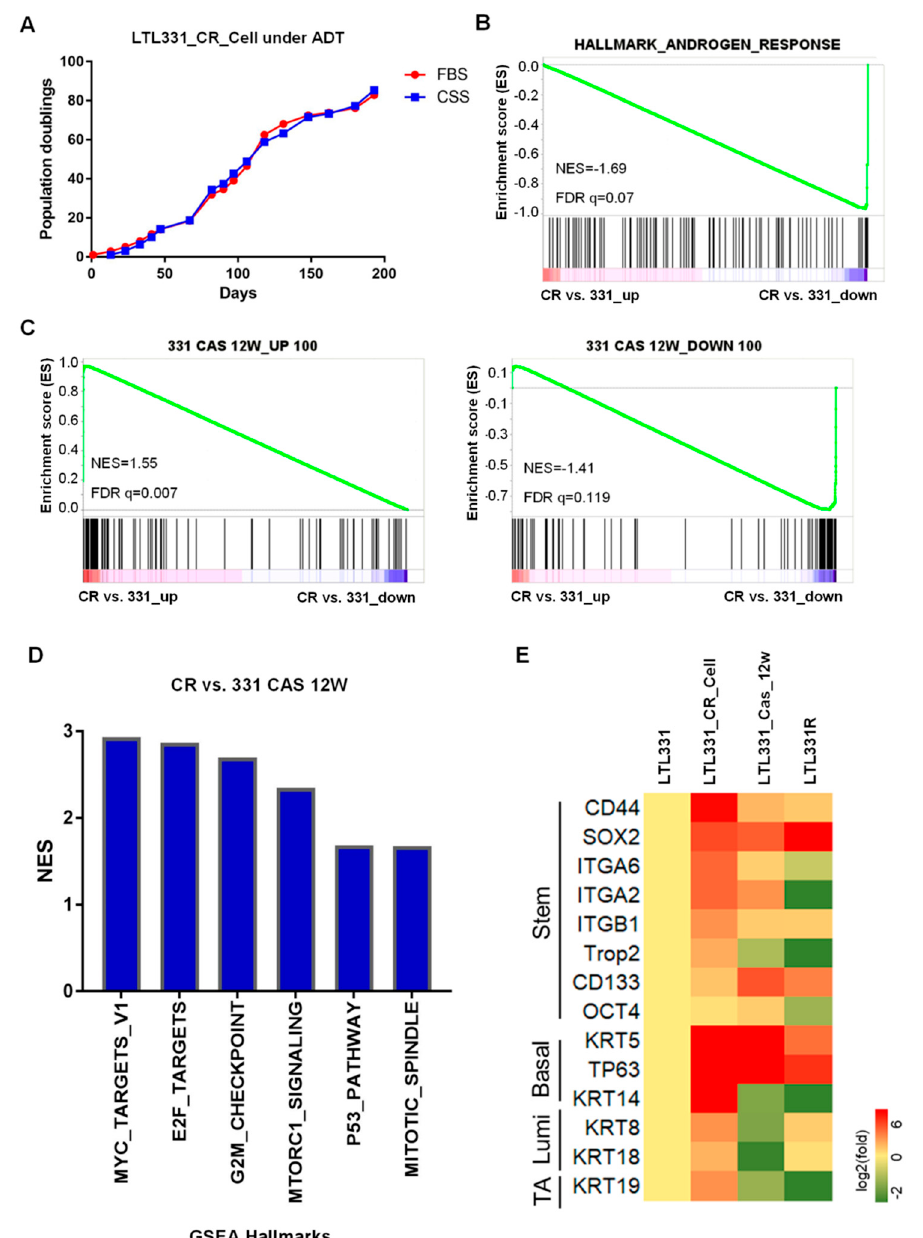
Figure 2. LTL331_CR_Cell is androgen independent with stem ‐ like features. ( A ). Growth curve of LTL331_CR_Cells under androgen deprivation therapy (ADT) conditions. CR cells were cultured in medium containing charcoal stripped serum (CSS) to mimic ADT. The cells were passaged and cell numbers were recorded at each passage. The blue curve shows cells grown in CSS ‐ containing medium, while the red curve shows cells grown in normal medium containing FBS. The red curve is the same as Figure 1C. ( B ) Inactivation of AR signaling in LTL331_CR_Cells. Transcriptomic analysis using gene set enrichment analysis (GSEA) shows that androgen response is downregulated in LTL331_CR_Cells compared to the parental LTL331. ( C ) The transcriptome of LTL331_CR_Cells partially resembles that of LTL331 post ‐ castration. The top 100 upregulated and downregulated genes from 12 ‐ week post ‐ castrated LTL331 were utilized as gene sets (i.e., 331 CAS 12W_UP 100, 331 CAS 12W_DOWN 100). GSEA comparing LTL331_CR_Cells to the parental LTL331 shows that a very similar set of castration ‐ response genes are upregulated (left panel) and downregulated (right panel). ( D ) GSEA shows that select cancer hallmarks are enriched in LTL331_CR_Cells compared to post ‐ castrated LTL331. The y ‐ axis represents normalized enrichment scores (NES). The nominal p ‐ values of all gene sets are less than 0.05. ( E ) Heatmap showing stem cell and cell lineage marker expression